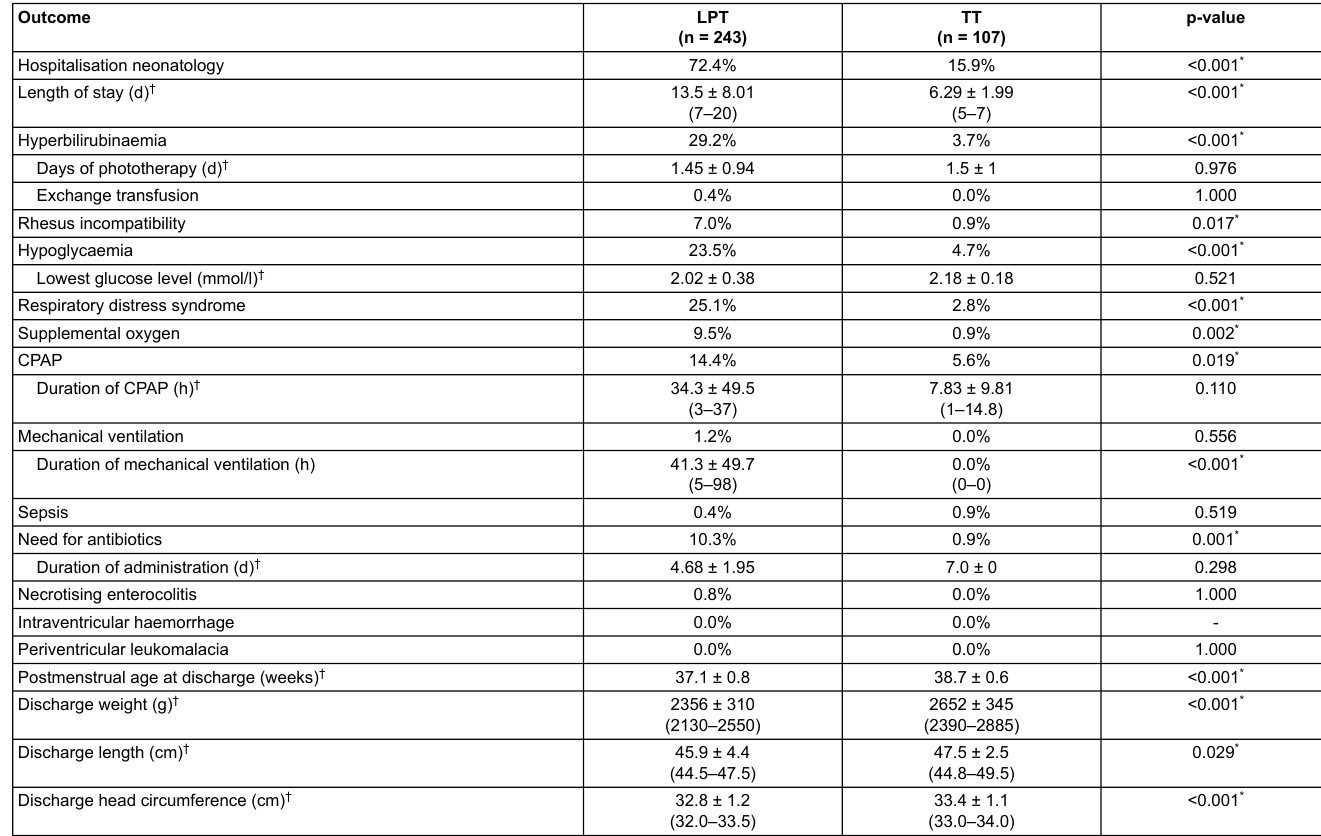
Table 5: Neonatal outcome of late preterm twins compared with term twins.